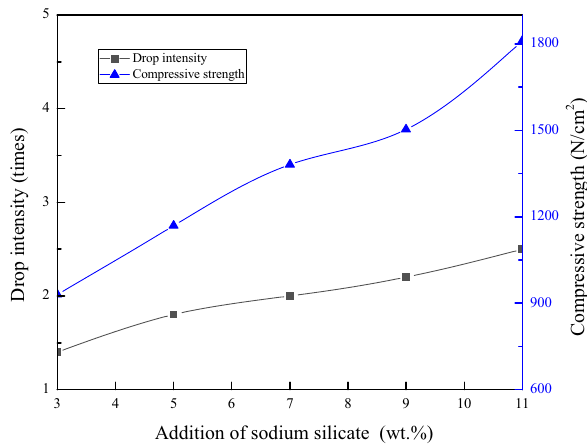
Figure 6: E ff ect of sodium silicate addition on the sample